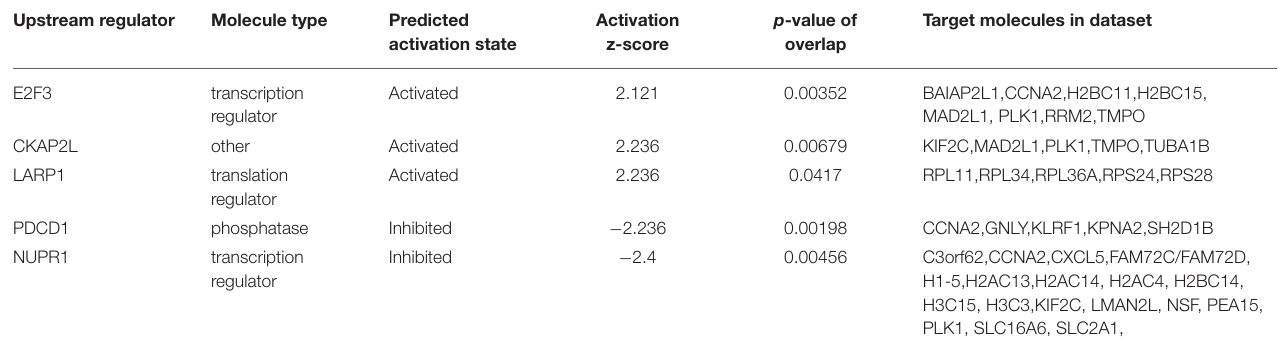
TABLE 6 | Key upstream